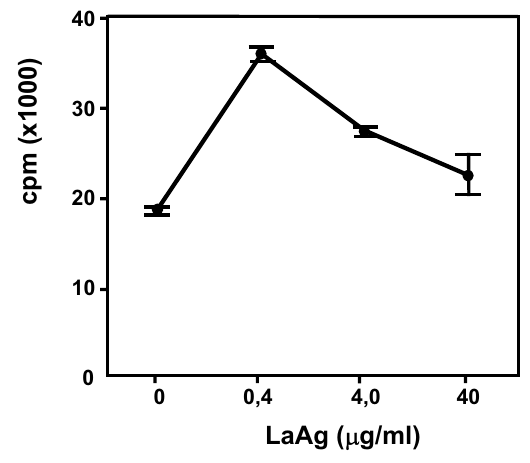
Fig. 4 – Effect of LaAg on anti-CD3-induced proliferation. Lymph node cells from 7-day infected mice were cultured in the presence of different LaAg concentrations for 1h. After this time, cells were transferred with LaAg to a 96-well plate ad- sorbed with anti-CD3. The proliferative response was measured 48 hours later. Mean ± SD (n=3).